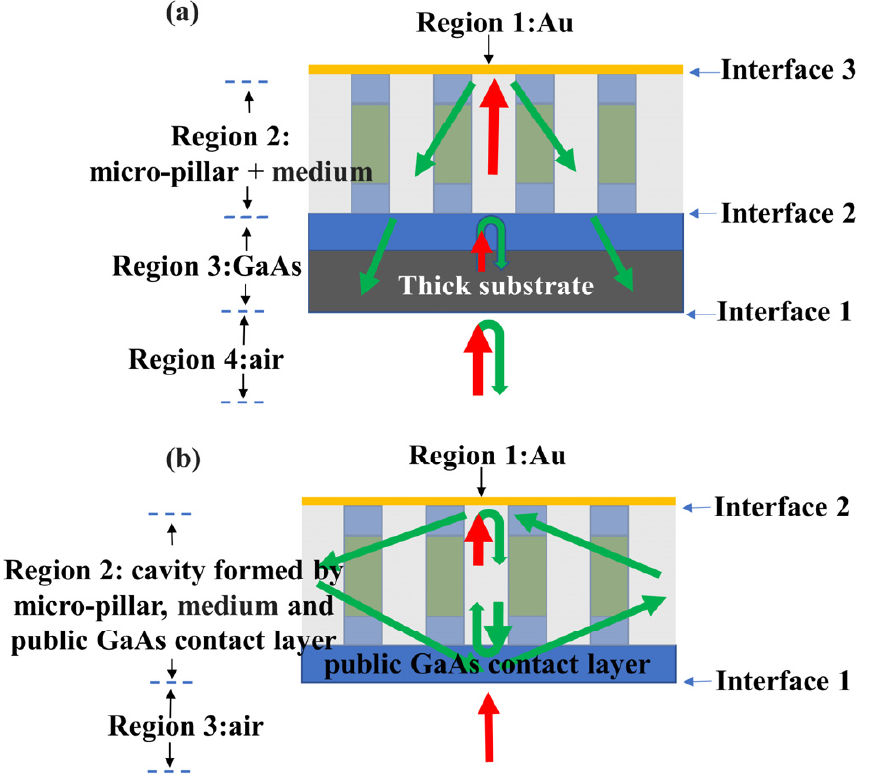
Figure 4. The optical path of ( a ) quantum well micropillar array with a thick substrate, ( b ) quantum well micropillar array with resonance-enhanced and antireflection effects.